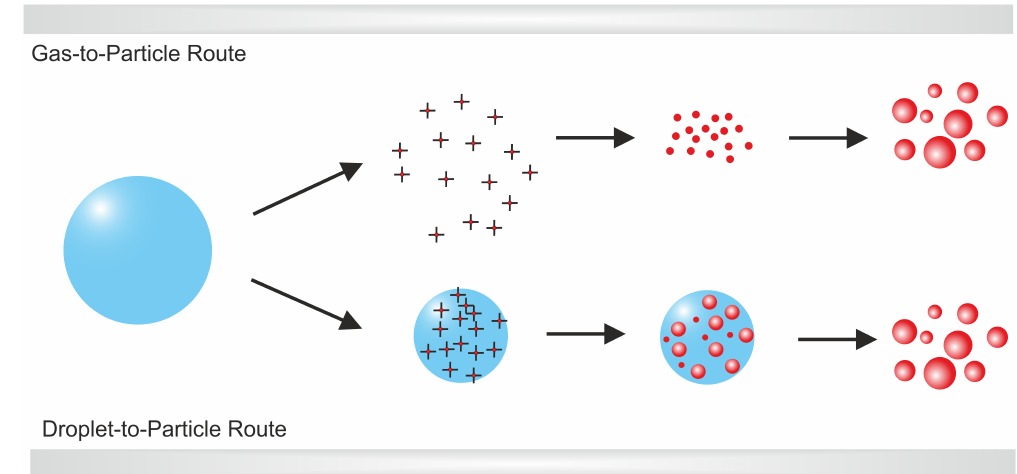
Figure 1. Overview of the particle formation mechanisms in flame spray pyrolysis (FSP) discussed in this